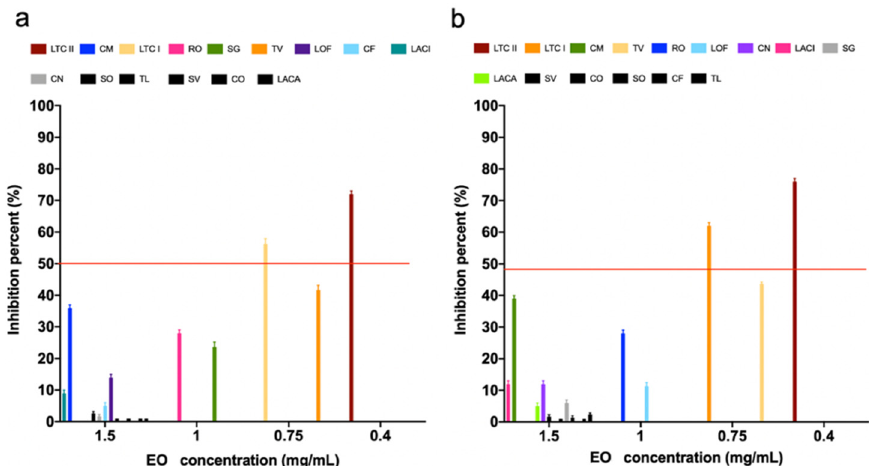
Figure 2. Inhibitory effect of EOs on biofilm formation of ( a ) S. aureus ATCC 29213 and ( b ) E. coli ATCC 25922. Data are presented as the mean ± SD of absorbance measured at 595 nm relative to the bacterial growth control.